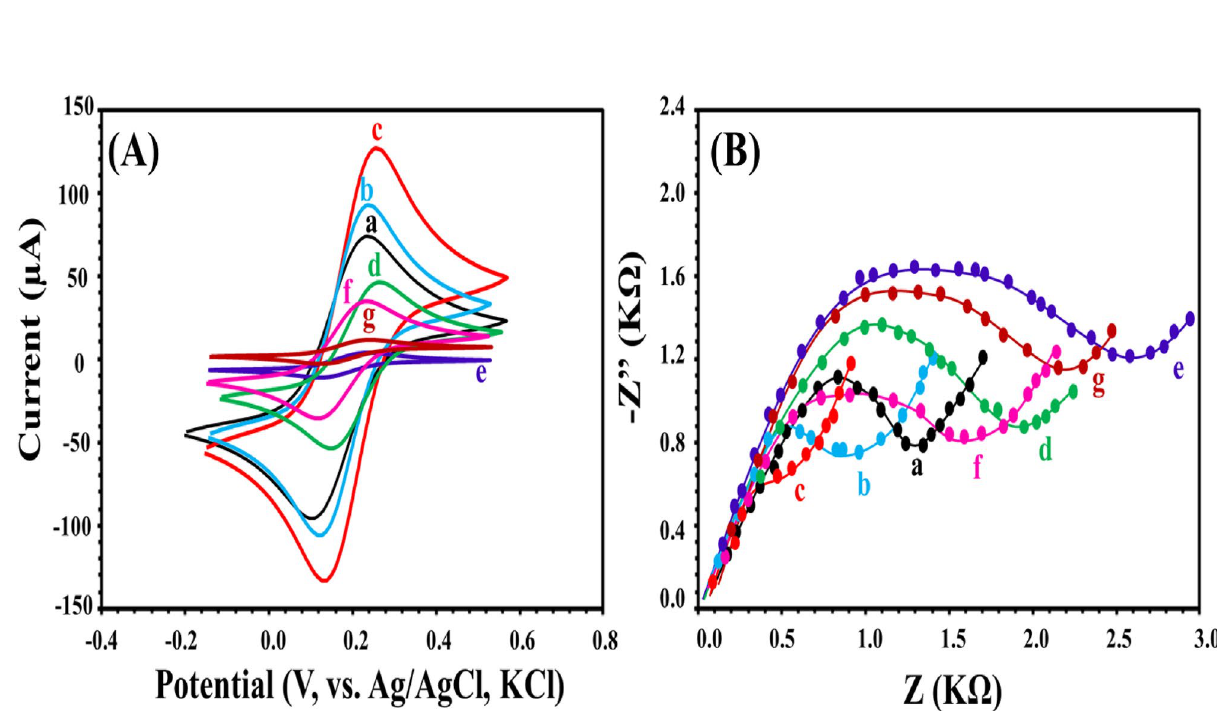
Figure 2. CV ( A ) and EIS ( B ) of bare GCE (a), Fe 3 O 4 /GCE (b), AuNPs@ Fe 3 O 4 /GCE (c), apt-AuNPs@ Fe 3 O 4 / GCE (d), NIP-apt-AuNPs@